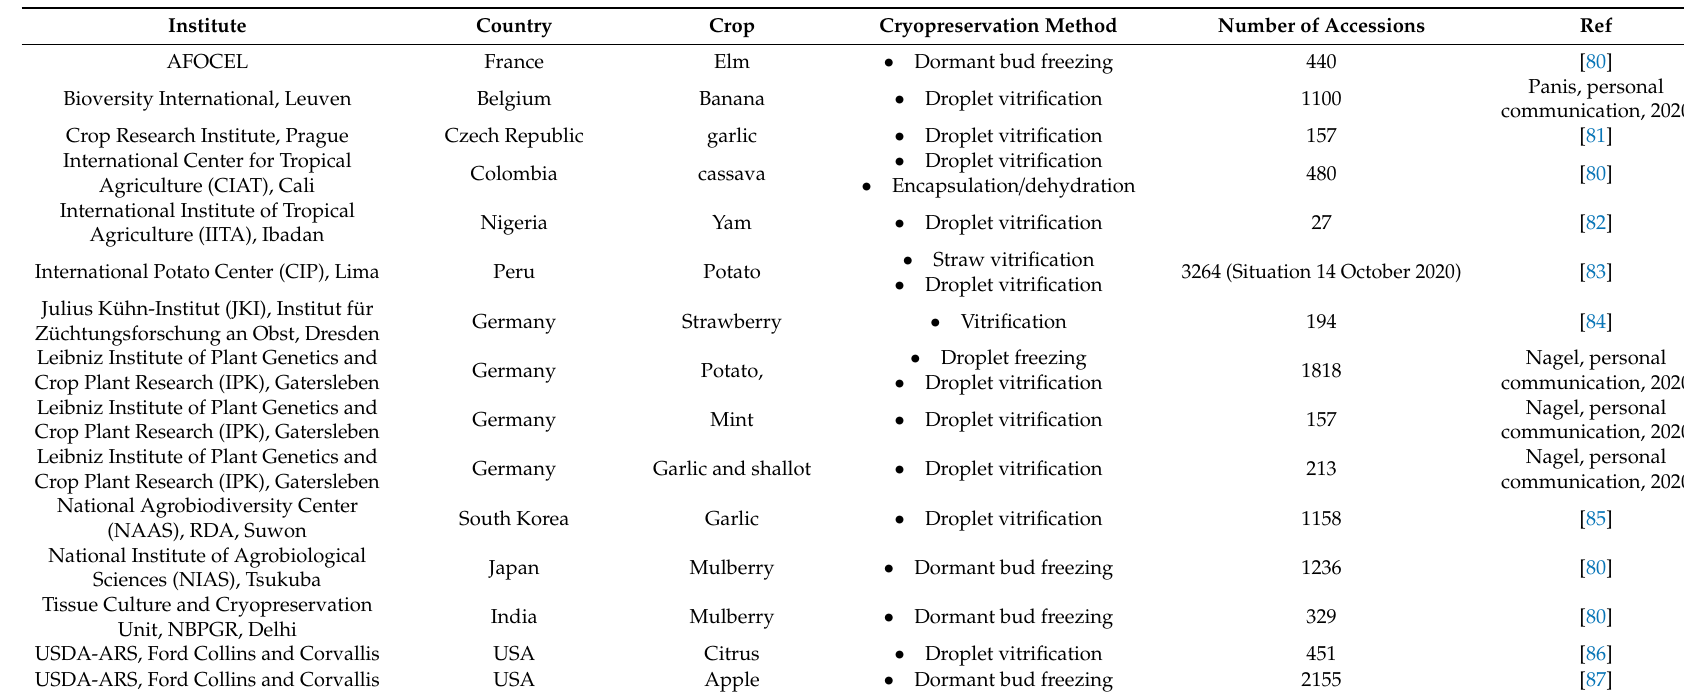
Table 1. Cryopreservation methods used in world’s largest crop genebanks that use cryopreservation for storage of their vegetatively propagated